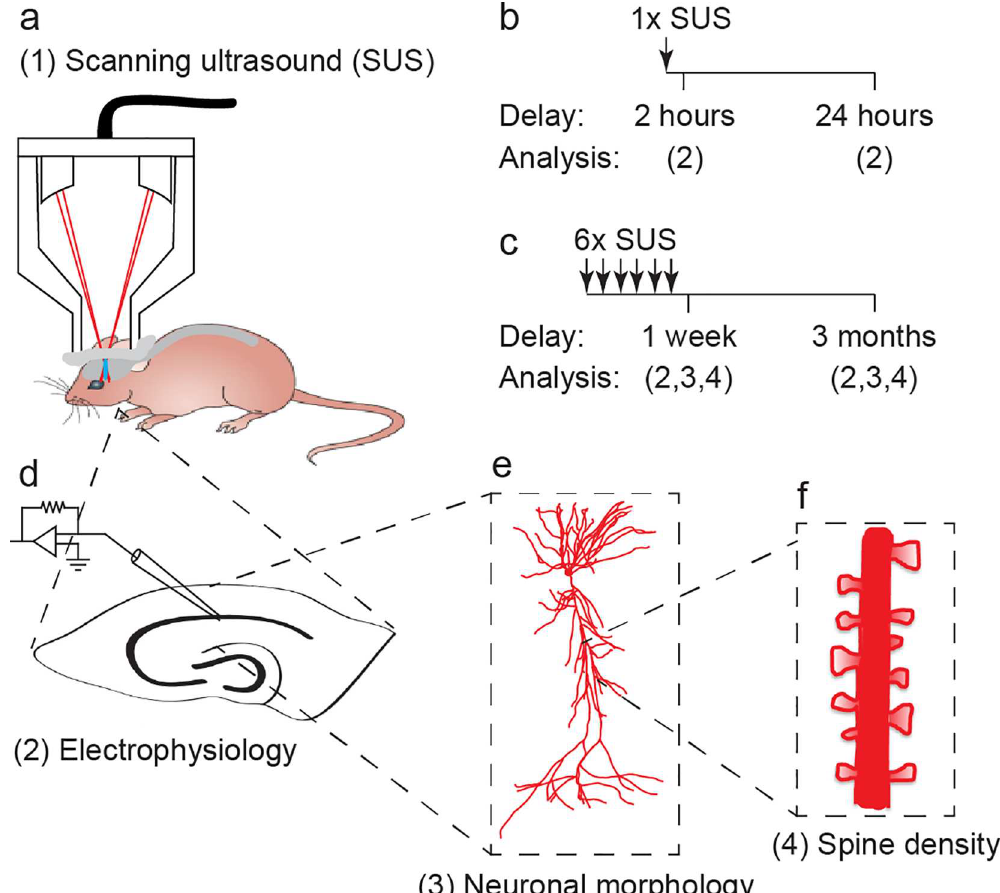
Fig 1. Overview of experimental study design. (a) Schematic of scanningultrasound(SUS) setup. (b-f) Treatment and experimental scheme. A cohort of wild-type mice was treated with (b) a single SUS treatment, and (d) electrophysiological recordings were performed 2 hours or 24 hours later to investigate the acute affects of SUS on neuronalexcitability. A second cohort of mice was treated with (c) six SUS treatments once per week for six weeks and allowedto age for one week or three months before (d) electrophysiology, (e) neuronalmorphology and (f) dendritic spine density were investigated to determine how SUS treatment affects neuronal excitability and synaptic